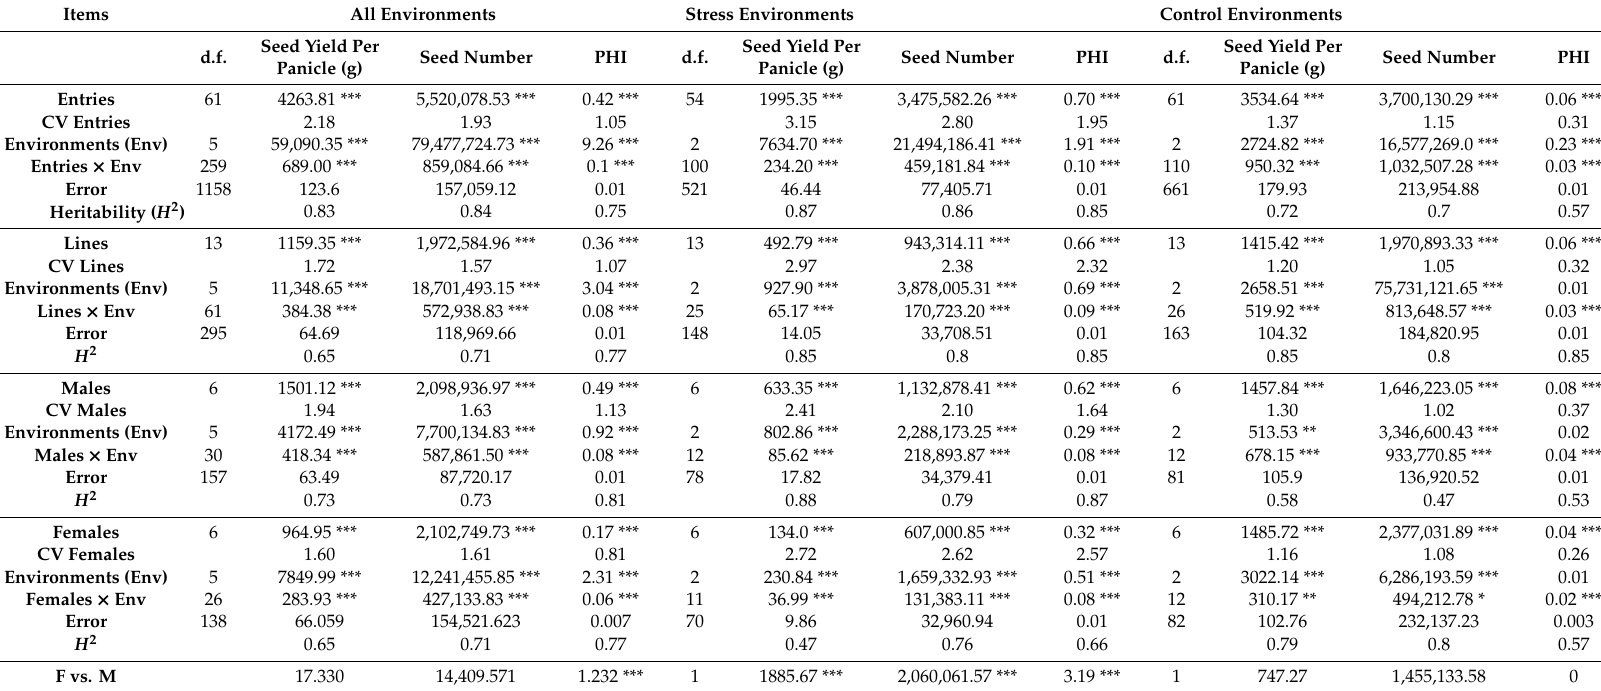
Table 3. Genotypic variances (mean squares) and their environmental interaction for the traits seed yield per panicle (g), seed number and panicle harvest index (PHI). (Stress environments: Asendorf, Poel 2017, Texcoco; control environments: Gross-Gerau, Poel 2018, San Juan del R í